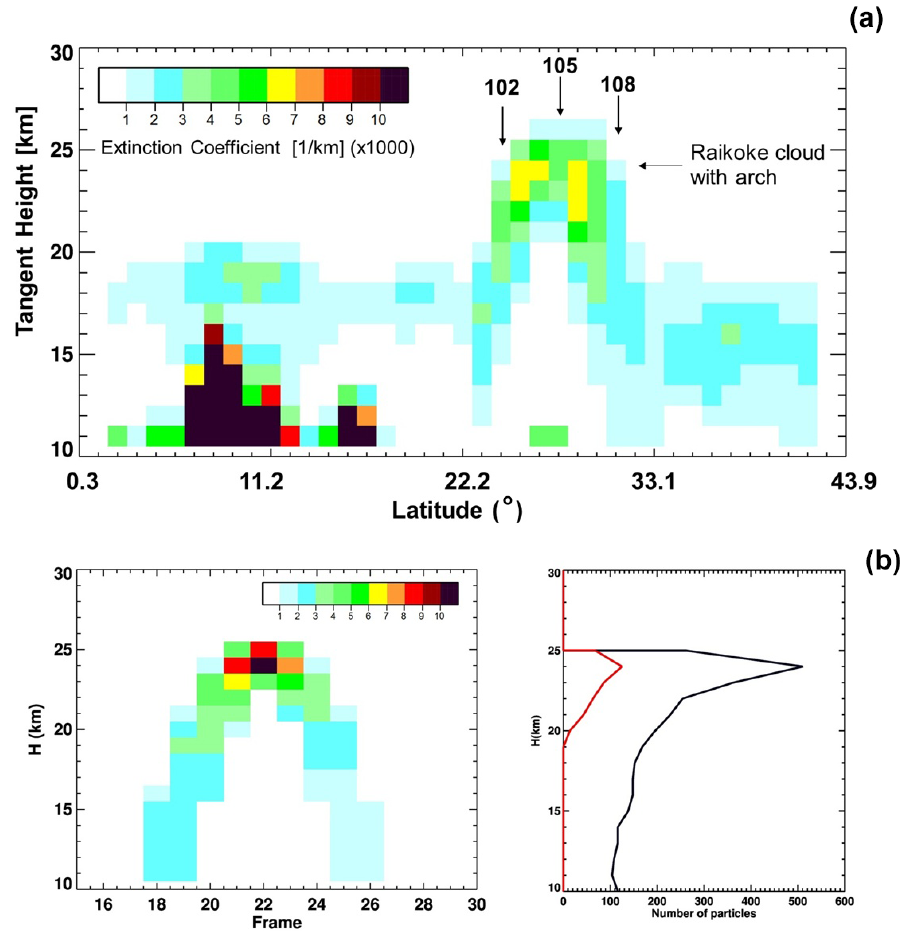
Figure 5. (a) The extinction coefficient profiles (674nm) from OMPS LP for the orbit 40636 (central slit, same orbit as in Fig. 12, which shows the profiles for events 102, 105, and 108) for 31 August 2019. To accurately calculate the extinction coefficient it is necessary to take into account the arch effect, which is clearly visible (OMPS LP data). (b) (Left) An arch that appears during the limb observation of an aerosol cloud 2km thick ( H = 23–25km) and 2 ◦ long. Each frame corresponds to a satellite orbital shift by 1 ◦ . Radiance from aerosol is proportional to the number of observed particles, taking into account the distance to them (the left part of the arch is slightly brighter than the right, because on frames 17–21 the cloud was closer to the satellite than on frames 23–27). The radiance units are arbitrary. (b) (Right) The red line is the profile of a cloud of 400 particles, which is observed on frame 22 (middle of the arch in Fig. 5a. The black line is the number of visible particles, summed over all frames, that is, over the entire arch.